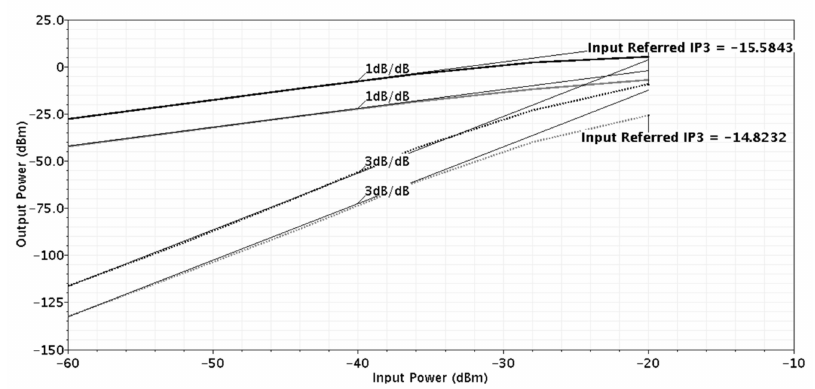
Figure 5. Simulated IIP3 curves with and without the recursive IF amplification